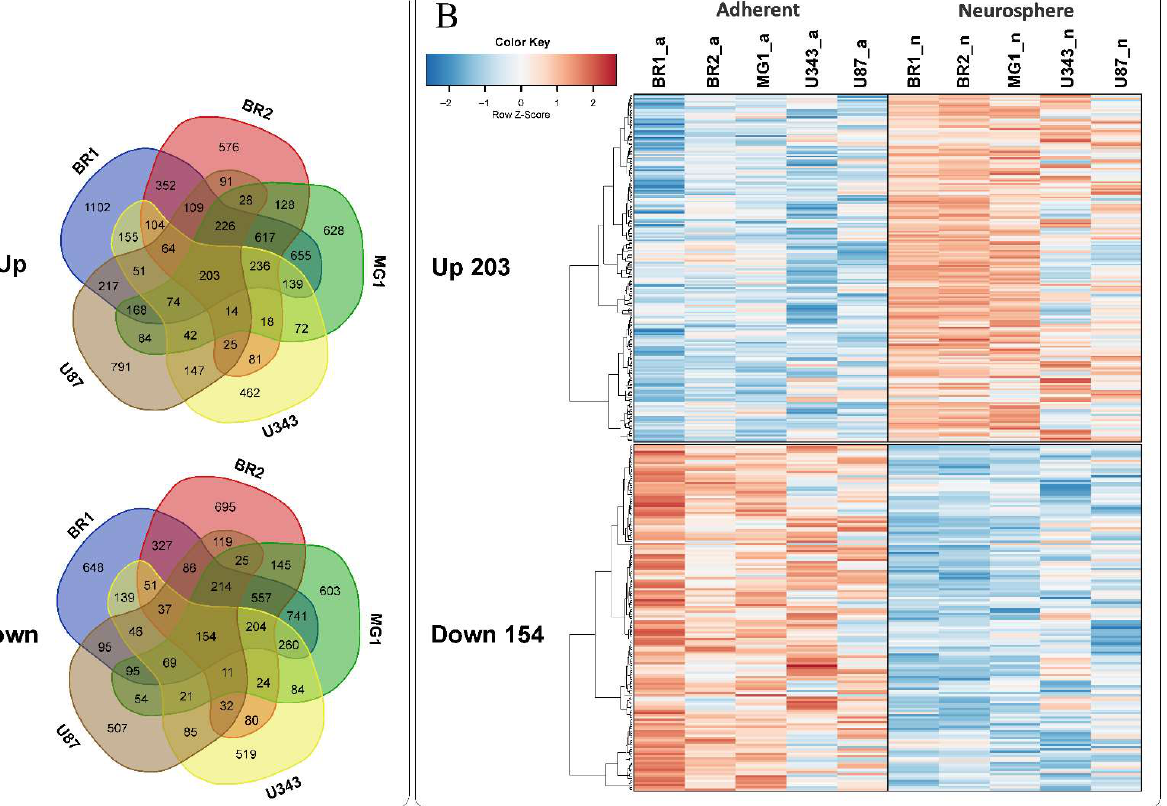
Table 2. Differentially expressed genes in MN/NS pairs of glioma cell cultures.